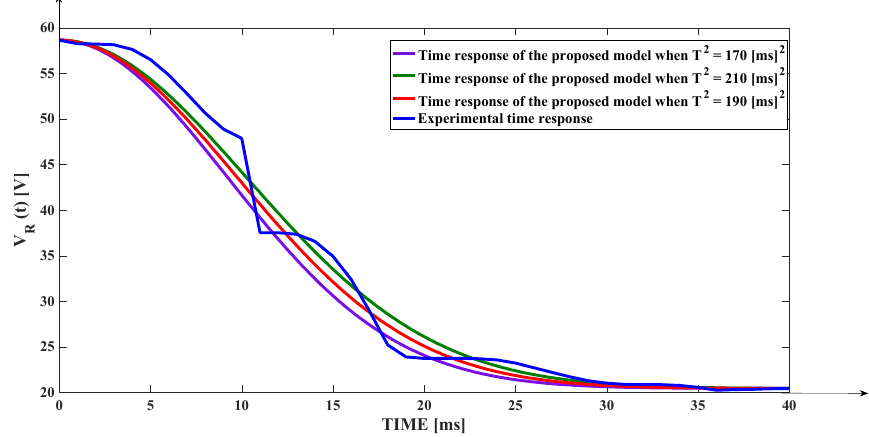
Figure 6. Different responses of the proposed Gaussian model.